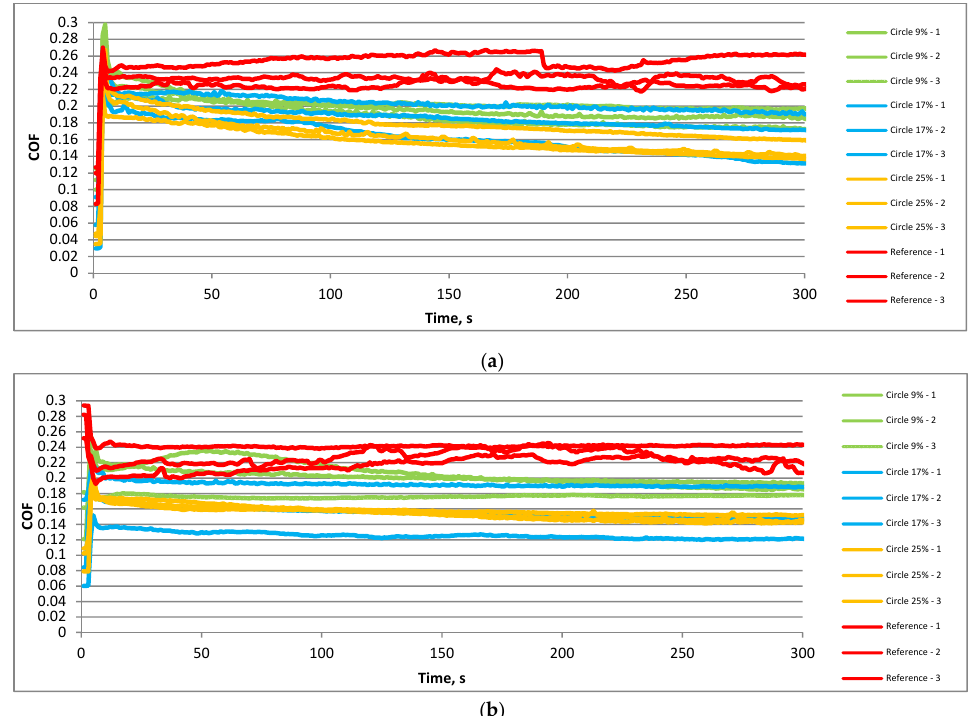
Figure 4. Courses of the coefficient of friction in the following operating conditions: f = 20 Hz; F = 40 N; T = 80 °C ( a ) and f = 20 Hz; F = 80 N; T = 80 °C ( b ).